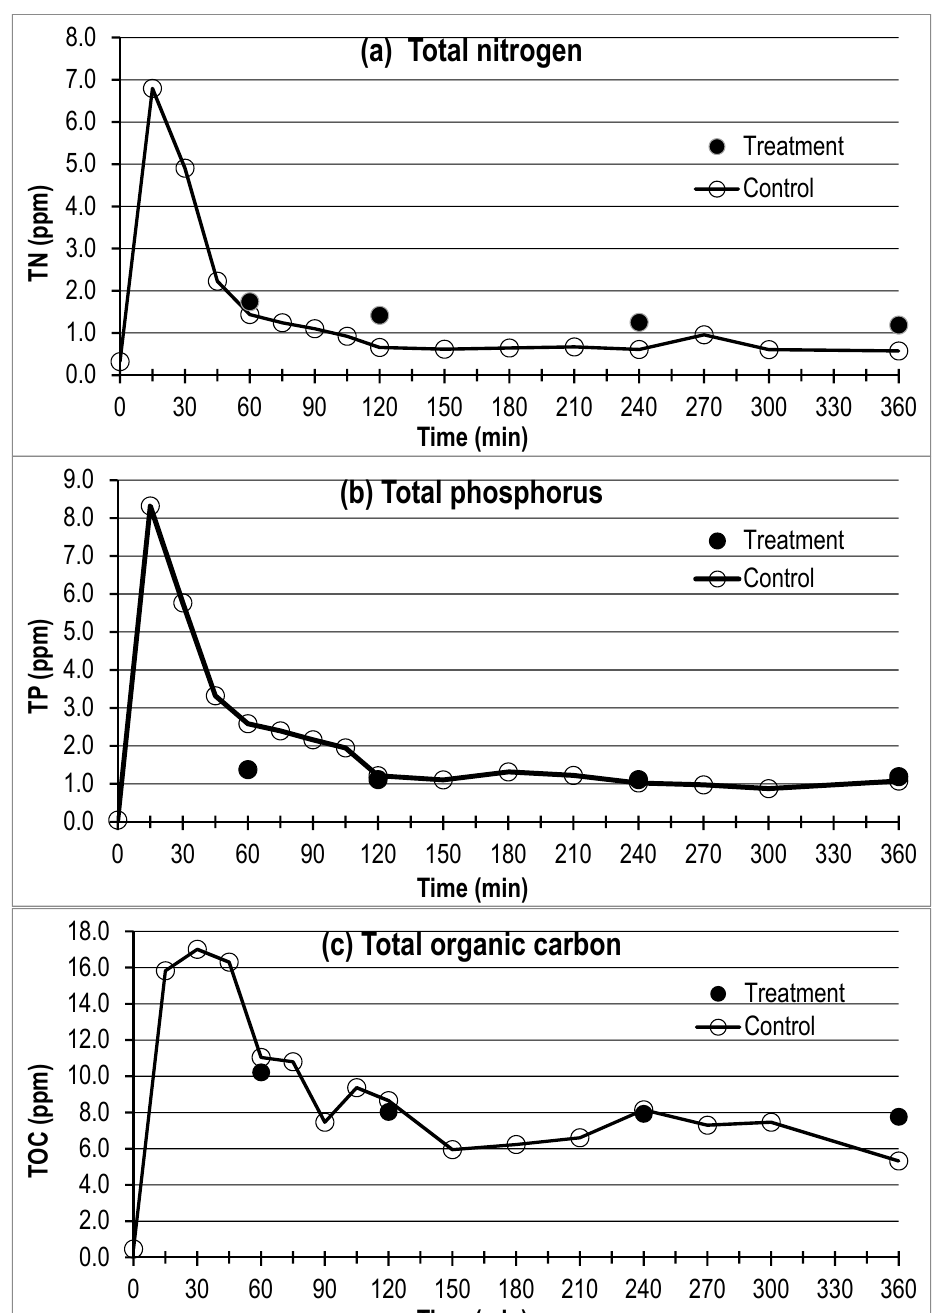
Figure 4. Temporal distribution of pollutant concentrations in the high pollutant loading experiment (( a ) Total nitrogen, ( b ) Total phosphorus, and ( c ) Total organic carbon). The concentration values at time zero are the background levels from the irrigation water source.